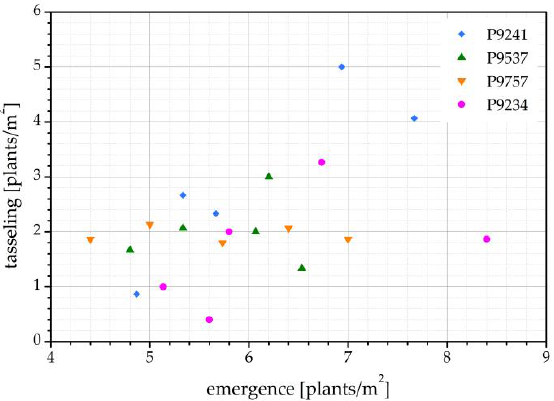
Figure 2. Correlation between the number of emerged seedlings (May) and the number of maize plants at tasseling (August) for the harvest year 2020.